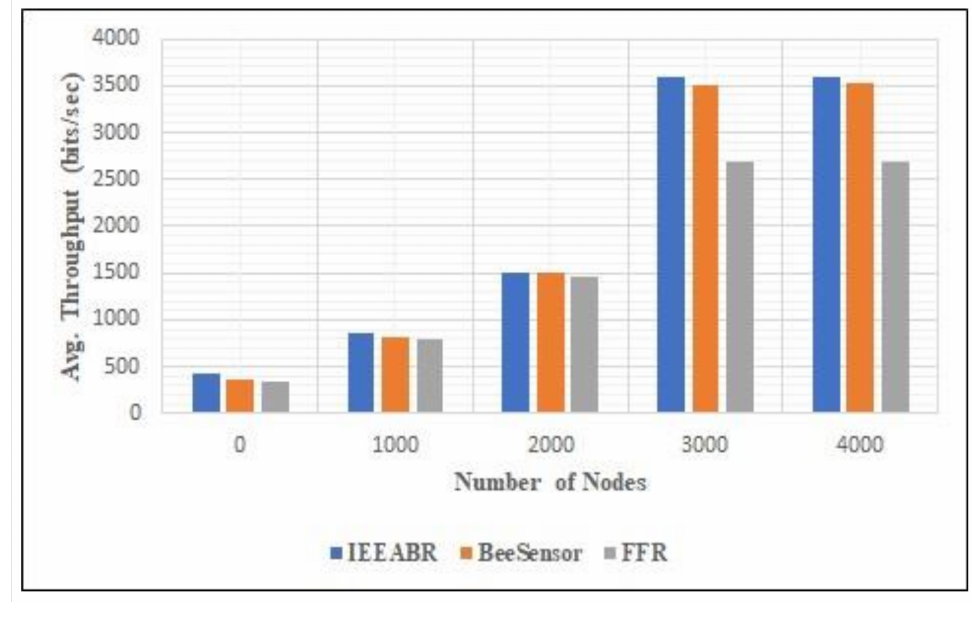
Figure 16. Average throughput.